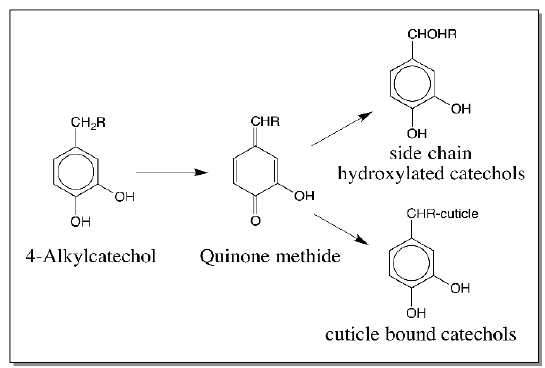
a specific dopamine- β -hydroxylase reaction.